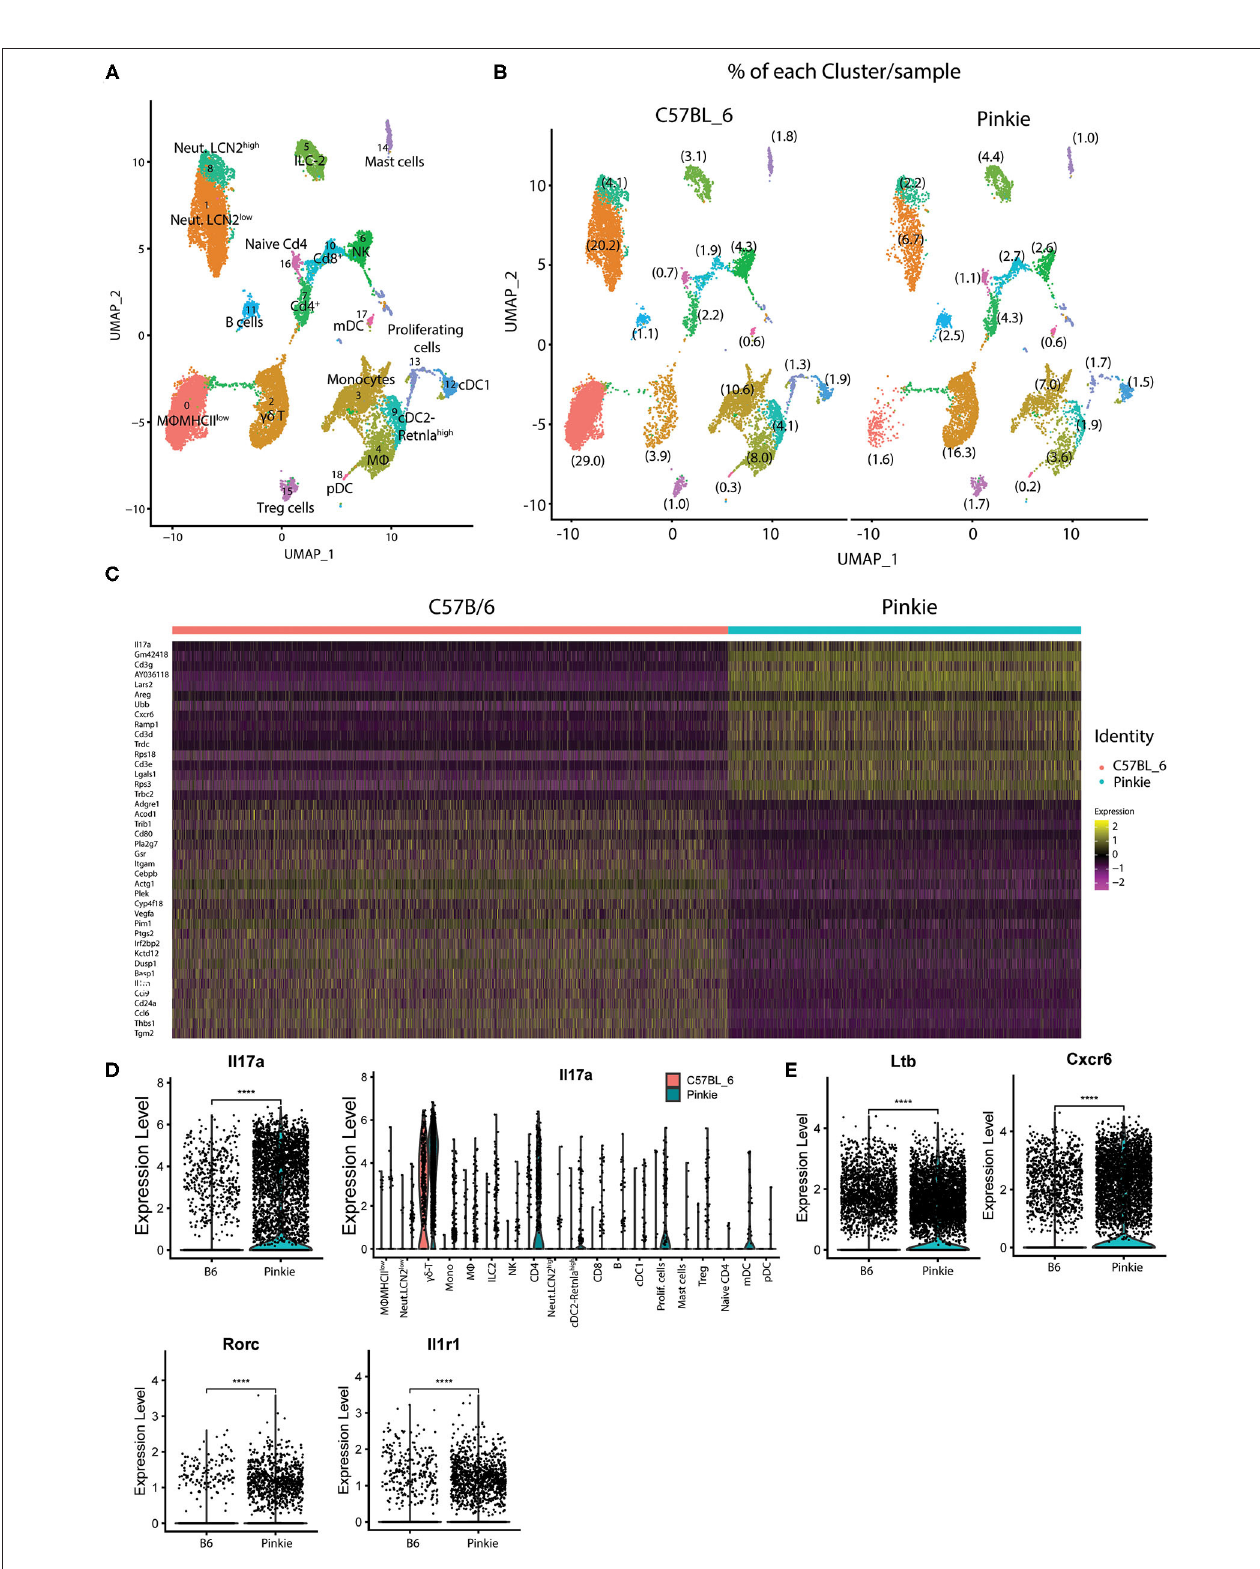
FIGURE 2 | Single-cell RNA sequencing. Single-cell RNA sequencing (scRNA-seq) revealed differences in conjunctival immune cell populations between B6 and Pinkie. (A) UMAP of 19 distinct immune cell clusters in the conjunctiva generated from single-cell transcriptomic profiles of CD45 + cells using Seurat package